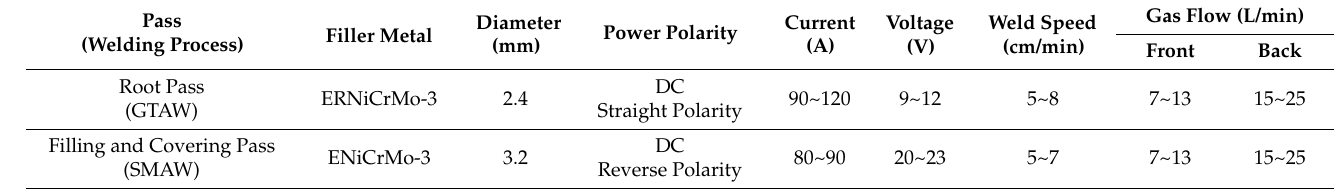
Figure 2. The groove form. Table 2. Welding